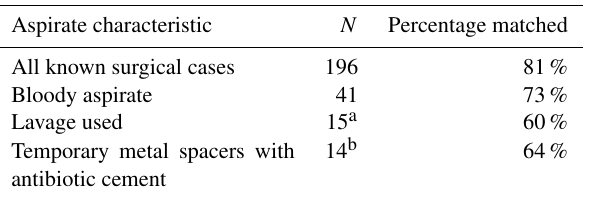
Table 8. Percentage of aspirate cultures that matched surgical cul-